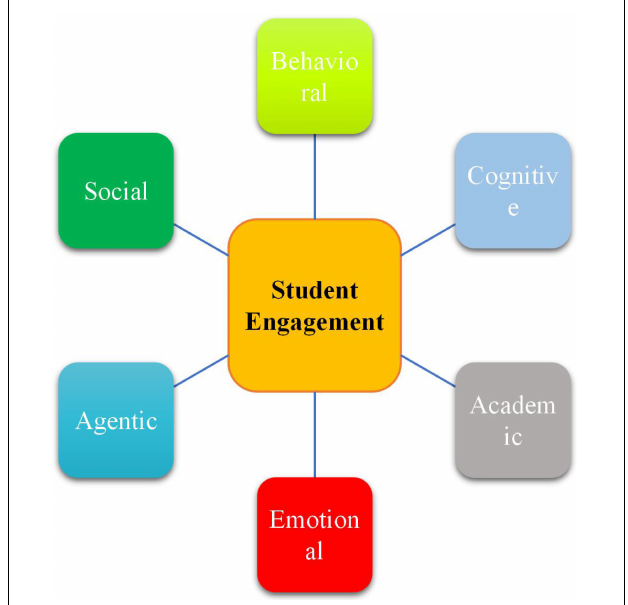
FIGURE 1 | The dimensions of student